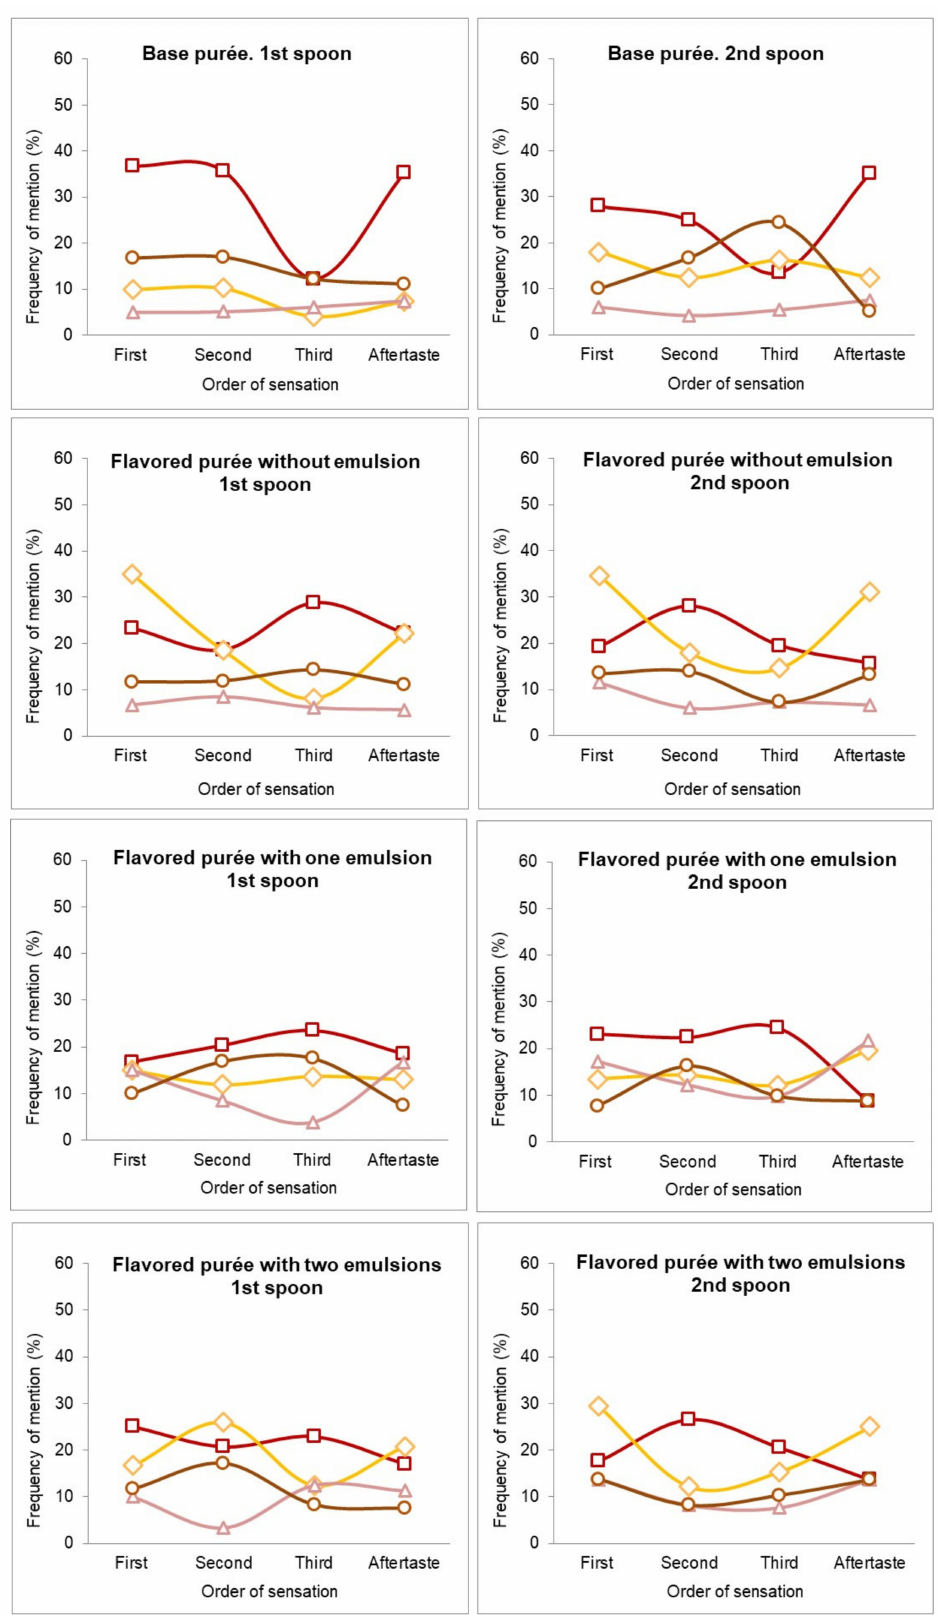
Figure 4. Free-TOS plots for flavor enriched pasta pur é es. Flavors represented are tomato ( (cid:3) ); cheese ( ♦ ); dry-cured ham ( ∆ ); and meat ( ) as first, second, and third sensations and aftertaste during the first and second (cid:35)